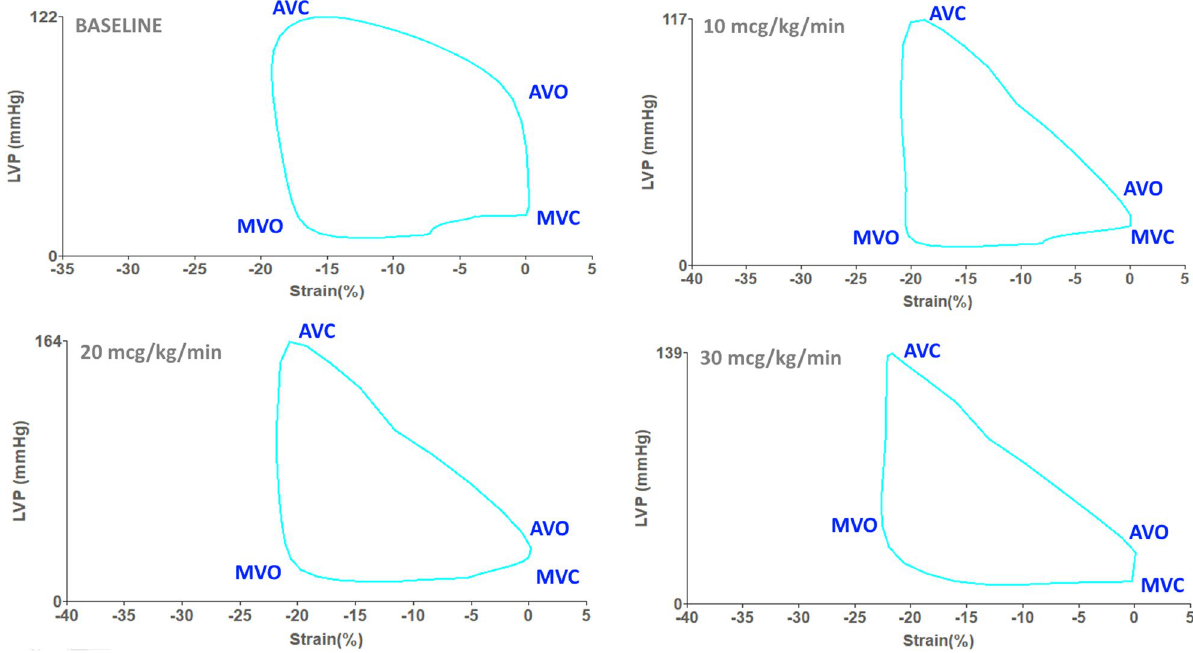
Figure 2. Pressure-strain loops during normal dobutamine stress echocardiography. LVP left ventricular pressure. MVC mitral valve closure, MVO mitral valve opening, AVC Aortic valve closure, AVO aortic valve opening. A small rise of strain results in a steeper increment of LV pressure during dobutamine stress